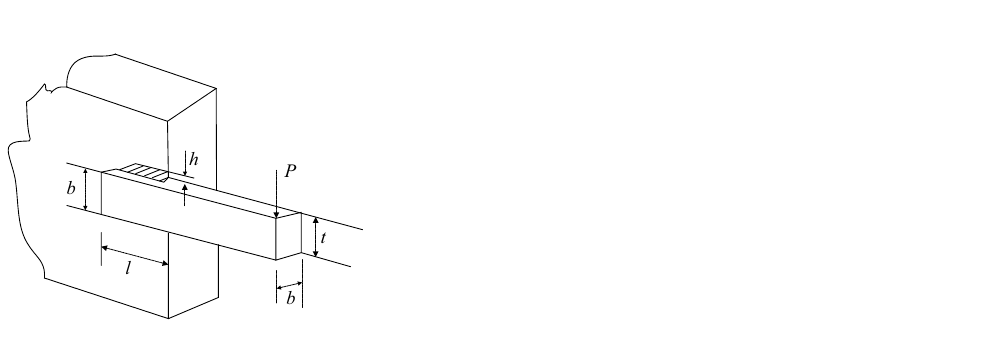
Table 14. Statistical result for tension string design problem. NA means not available; a means infeasible. Significant values are in bold.